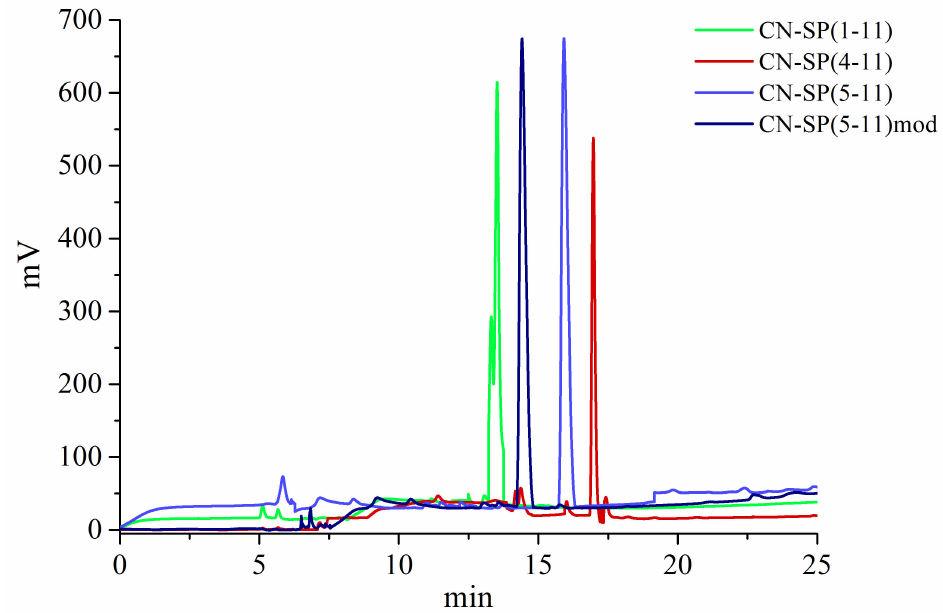
Figure 8. HPLC chromatograms (system 1) of purified CN-SP(1–11), CN-SP(4–11), CN-SP(5–11) and CN-[Thi 8 ,Met(O 2 ) 11 ]SP(5–11) bioconjugates.